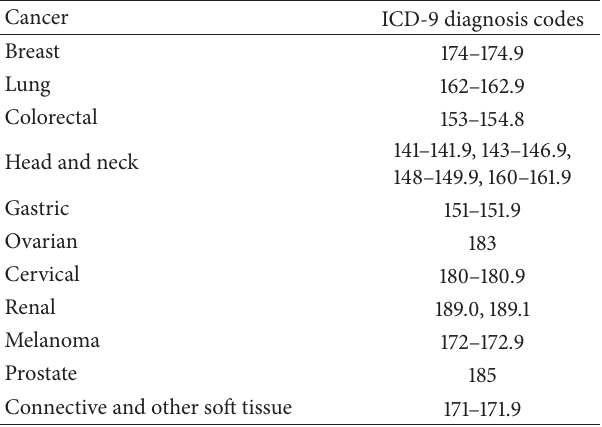
Table 1: ICD-9 diagnosis codes for cancer types of